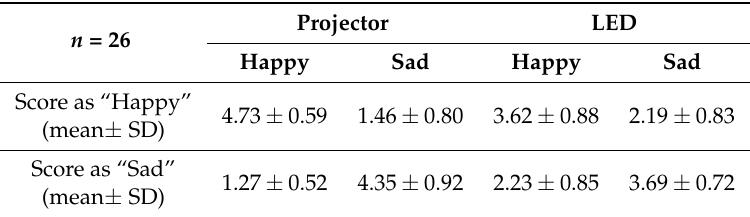
Table 2. Mean and standard deviation of participant’s answer as “Happy” or “Sad” to each stimuli. n =